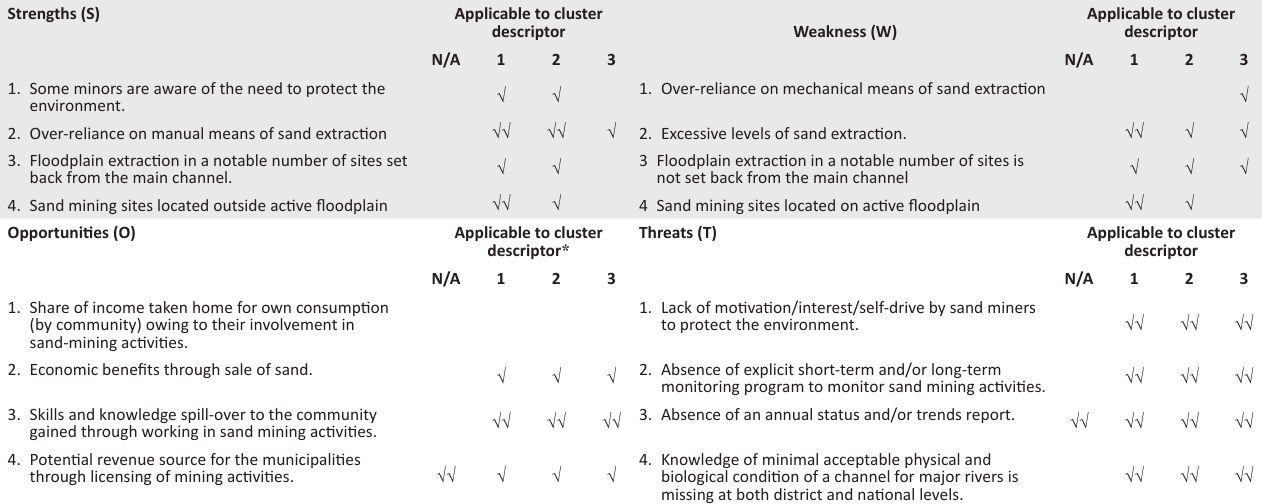
NB: Only a sample of variables is presented. In total, 13 strengths, 20 weaknesses, 18 opportunities and 11 threats were identified. * , Cluster descriptor number informed by K -means cluster solution presented earlier on in the analysis. N/A: Not applicable to any of the sand mining sites in the cluster. √ , Applicable to some sand mining sites in the cluster. √√ , Applicable to all sand mining sites in the